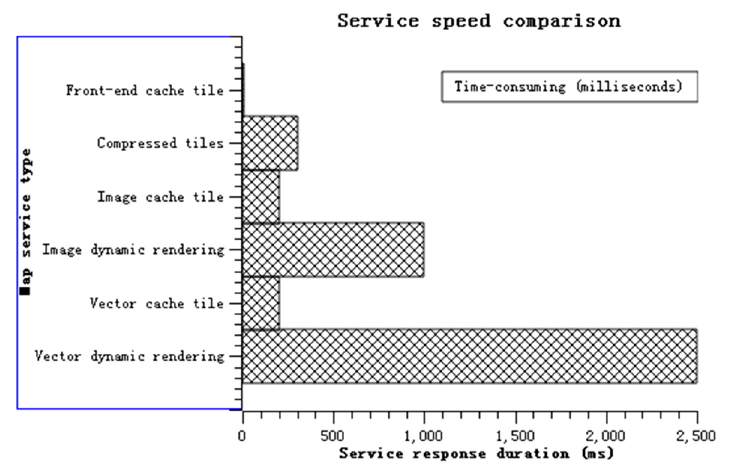
Figure 15. Comparison of response speeds of di ff erent map service types. As shown, vector dynamic rendering requires more CPU and memory, which takes the longest amount of time; in addition, image